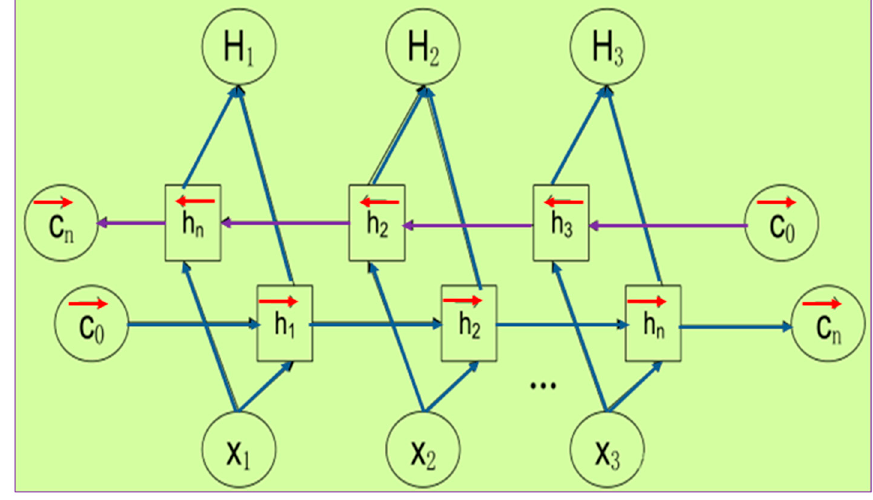
Figure 5. BiLSTM principle.